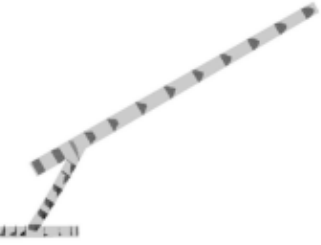
Fig. 6 - Velocity profiles along the geometric model: subclavian artery, PTFE graft and pulmonary branches